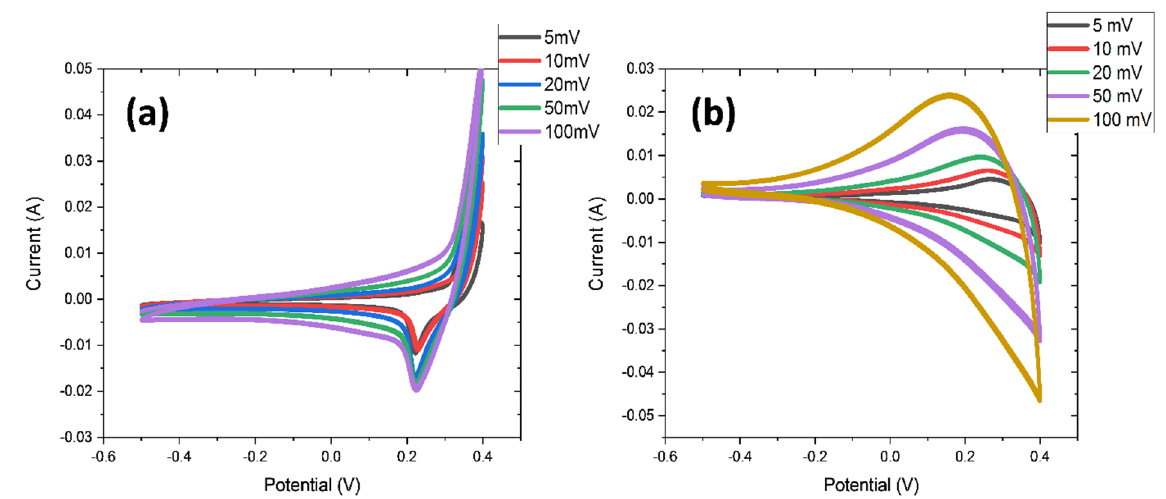
Figure 5. ( a ) CV curves of NZF at the potential window of − 0.5 to 0.4 V; ( b ) CV curves of NZF@NF at the potential window of − 0.5 to 0.4 V.